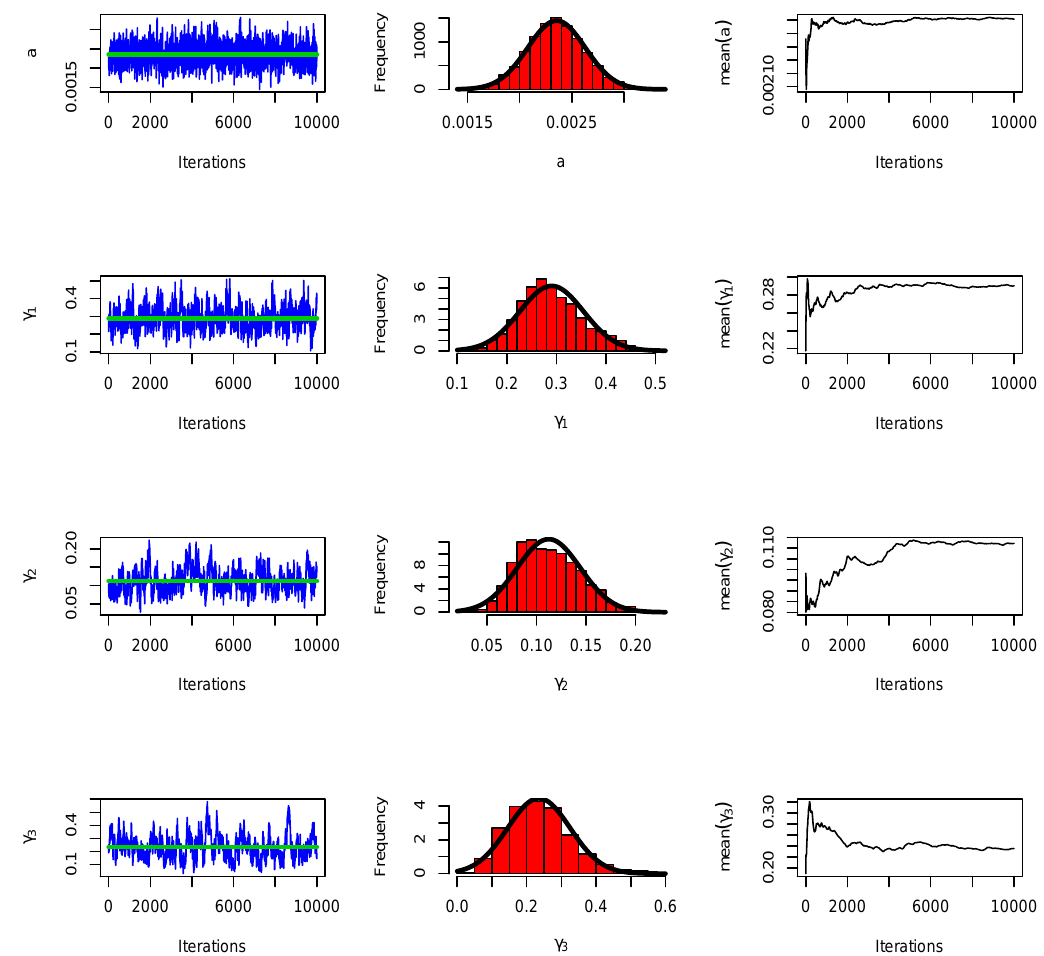
Figure 8. The MCMC plots for data set I using the BBXEx model. Figure 8. The Markov chain Monte Carlo (MCMC) plots for data set I using the BBXEx model.